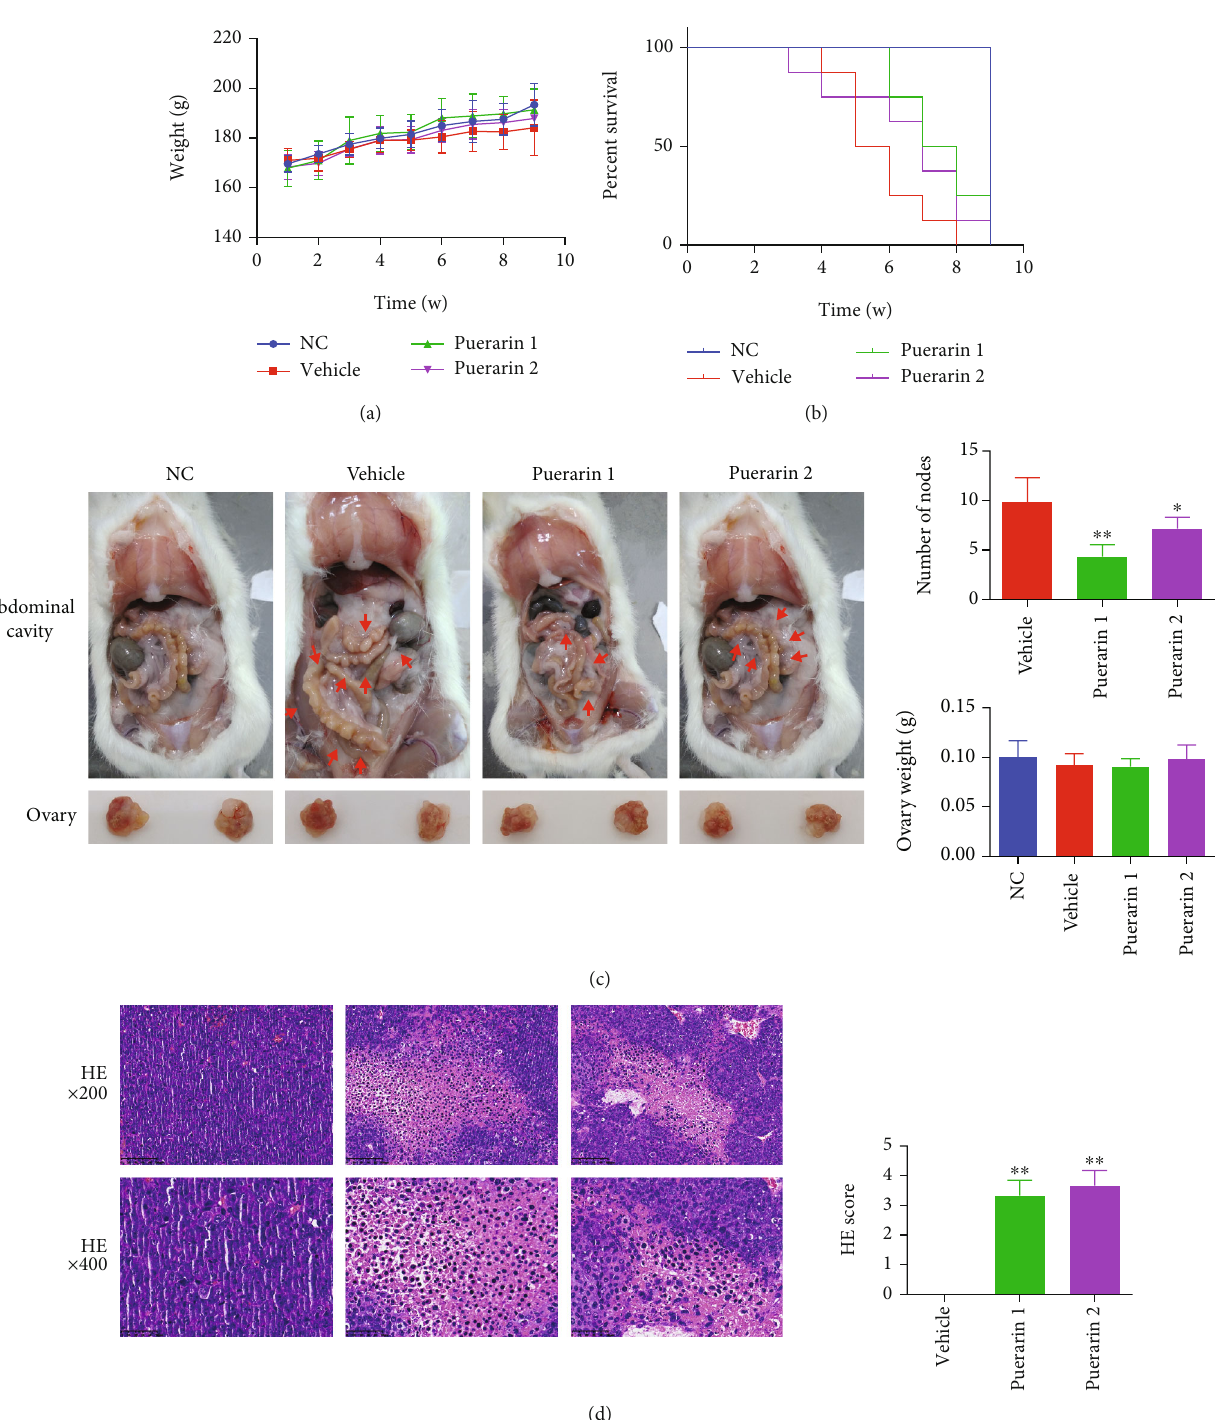
Figure 3: Puerarin inhibits ovarian tumor formation in Fischer 344 rats. (a) The change in bodyweight was recorded during the experiment. (b) The survival of the rats was recorded during the experiment. (c) The tumor nodes in the abdominal cavity of each group of rats were counted, and the ovarian weight was determined. (d) HE staining of the tumor tissues (magni fi cation: × 200, 400). The data are presented as mean ± SD . ∗ p < 0 : 05 , ∗∗ p < 0 : 01 , compared to the vehicle